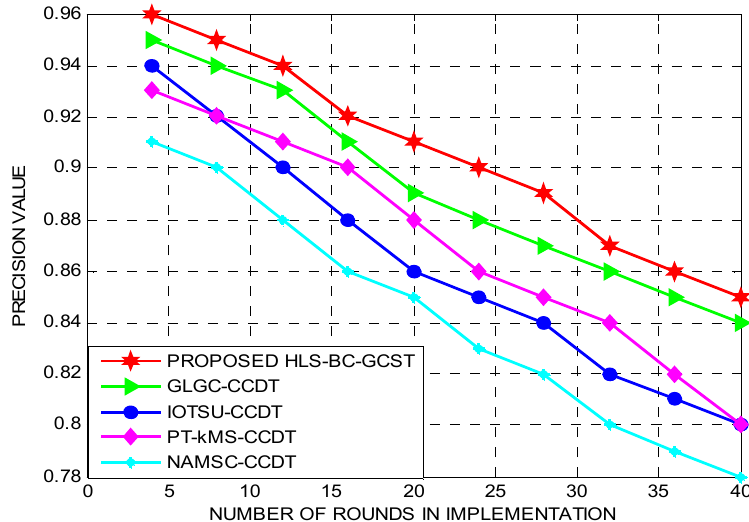
Figure 8. The proposed HLC-BC-GCST scheme evaluated using a precision value.